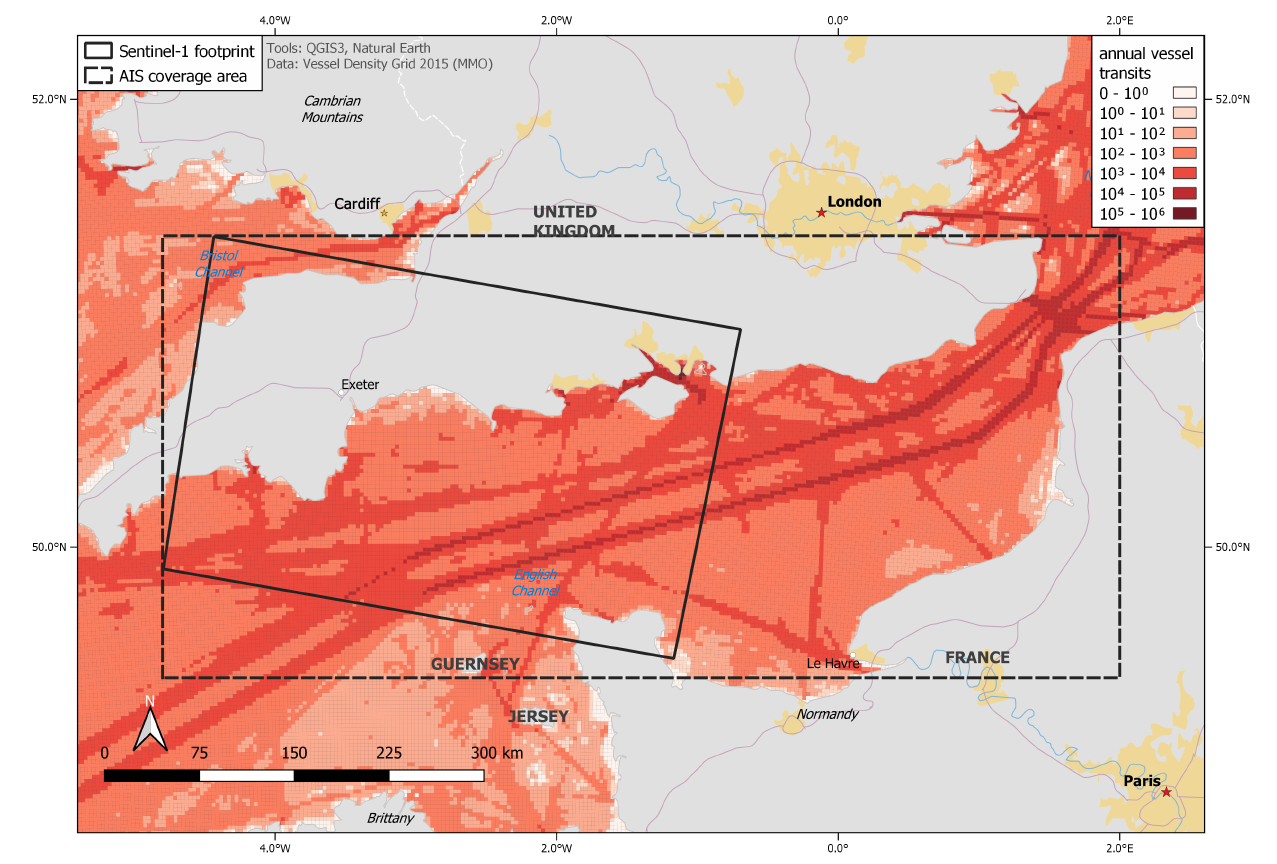
Figure 8. English Channel AIS coverage area (2 km grid resolution).